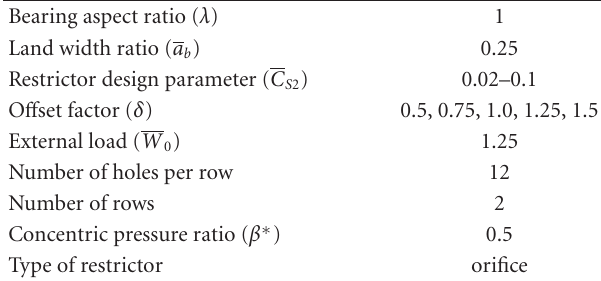
Table 1: Bearing operating and geometric parameters.